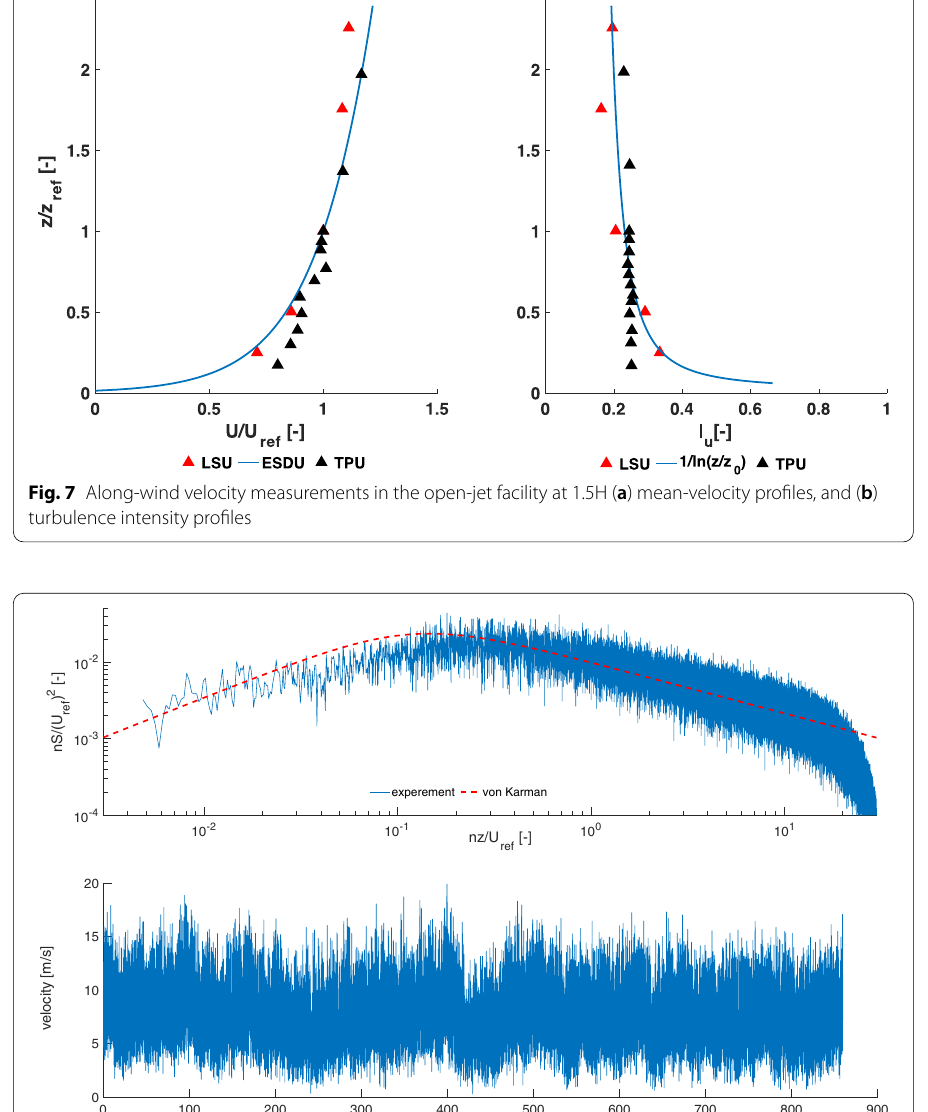
Fig. 8 Velocity spectrum and time